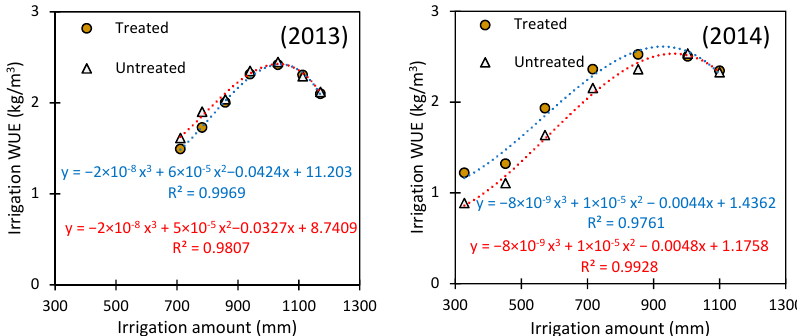
Figure 6. Irrigation water use efficiency of alfalfa as function of irrigation amount at each cut during the 2014 growing season.